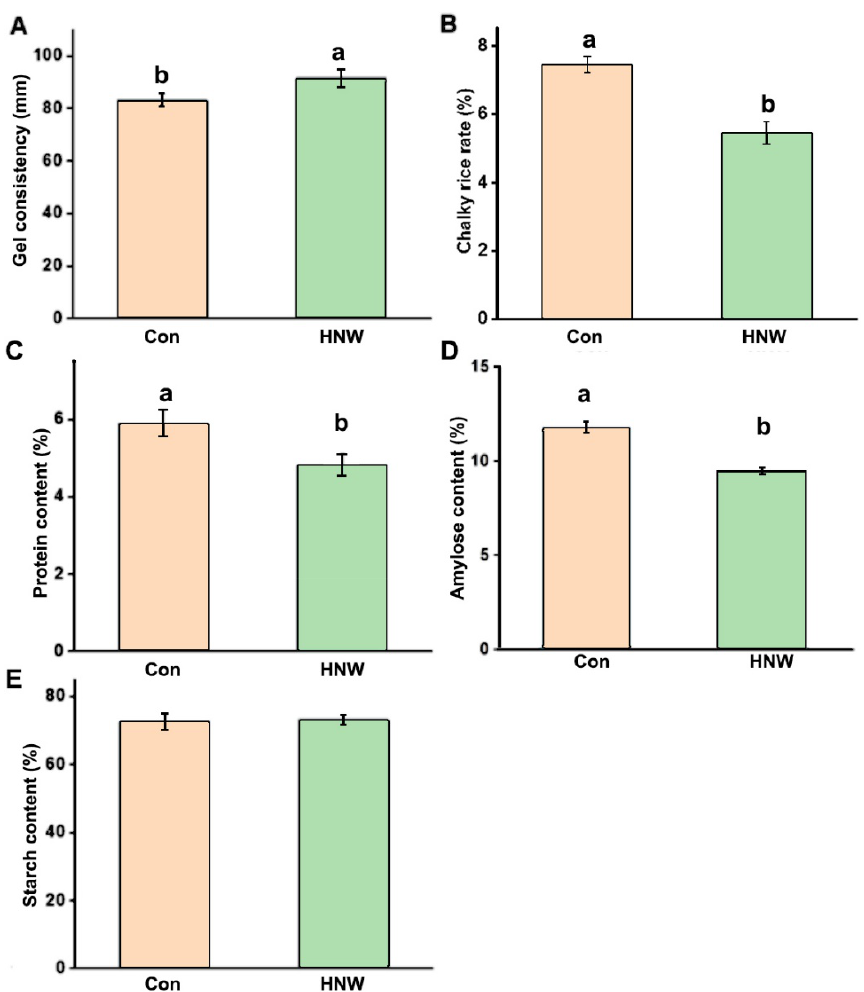
Figure 5. HNW positively influences qualitative characters of white rice. The gel consistency ( A ), chalky rice rate ( B ), contents of total protein ( C ), amylose ( D ), and starch ( E ) were analyzed. Data are mean ± SD (n = 3). Bars with different letters were significantly different in comparison with Con at p < 0.05.